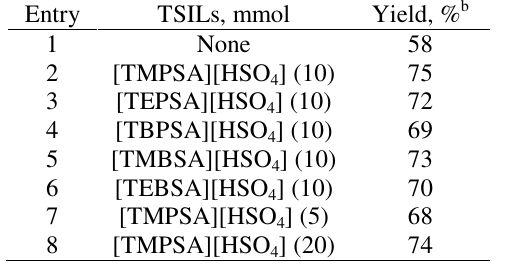
Table 1. Synthesis of DPT catalyzed by different a TSILs Entry TSILs, mmol Yield, %